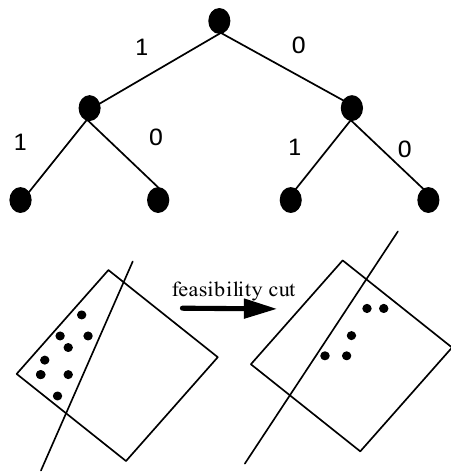
Figure 3. Principle of feasibility cut acceleration technique.